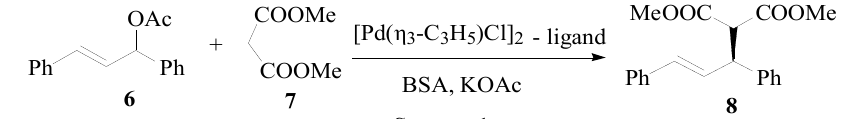
Scheme 1. The model reaction of palladium-catalyzed asymmetric allylic alkylation.